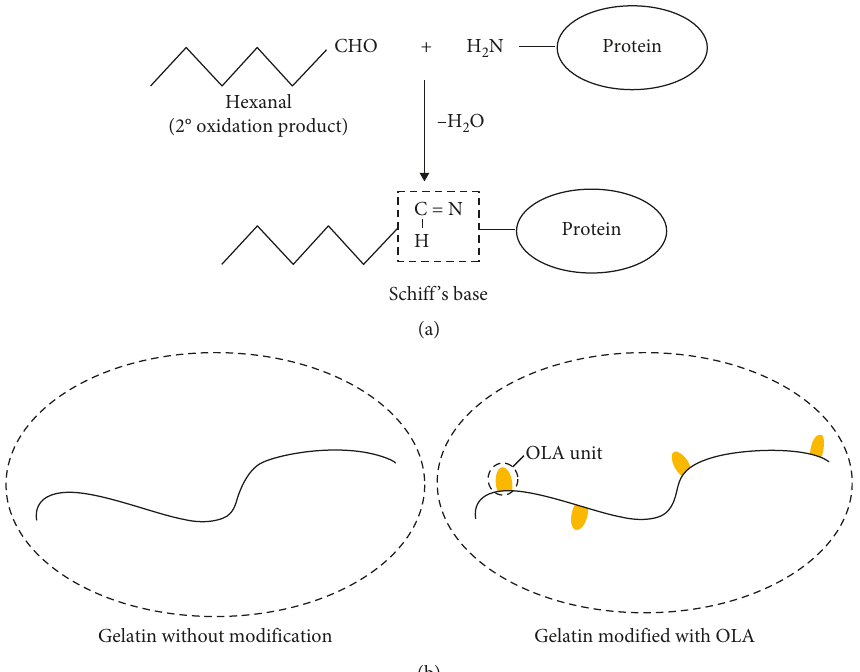
Scheme 2: Reaction between secondary oxidation products of OLA and gelatin (a) and molecular model for gelatin chain without and with OLA modification